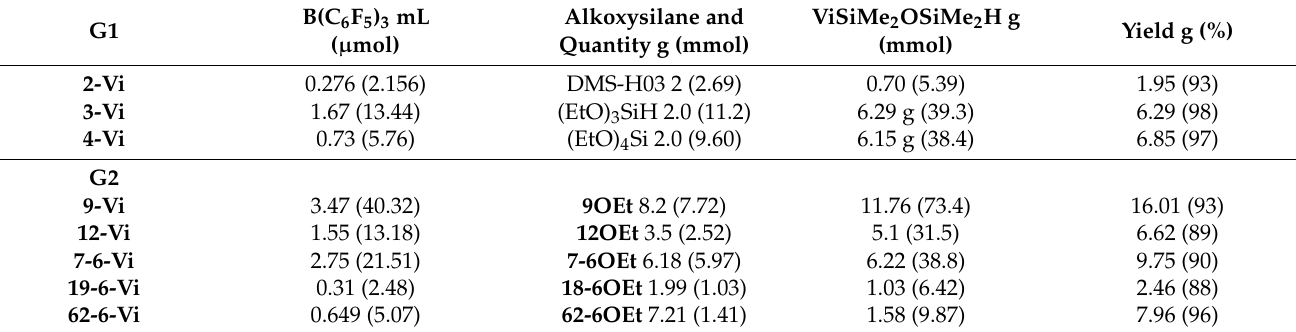
Table 1. Quantities used to prepare vinylsilicones from